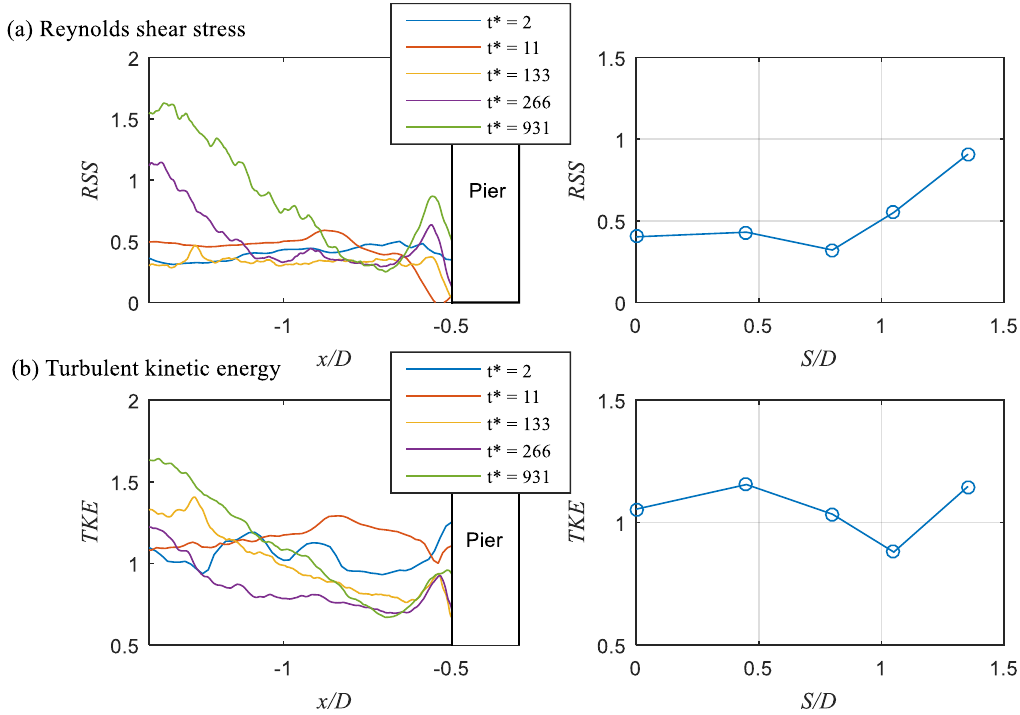
Figure 14. Reynolds shear stress and turbulent kinetic energy along the center line at different time in the pier scouring process and the corresponding space-averaged value versus dimensionless pier scour depth. ( a ) Reynolds shear stress, ( b ) turbulent kinetic energy.